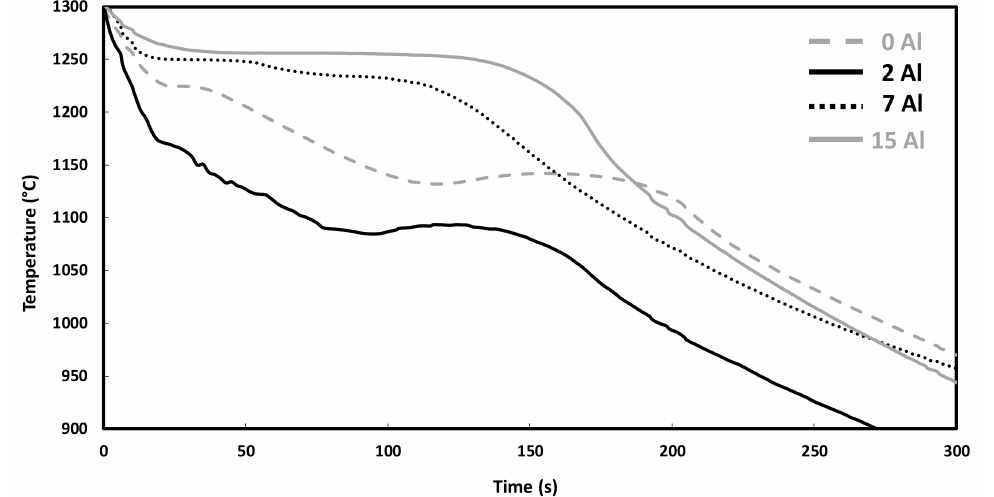
Figure 5. The cooling curves of the studied cast